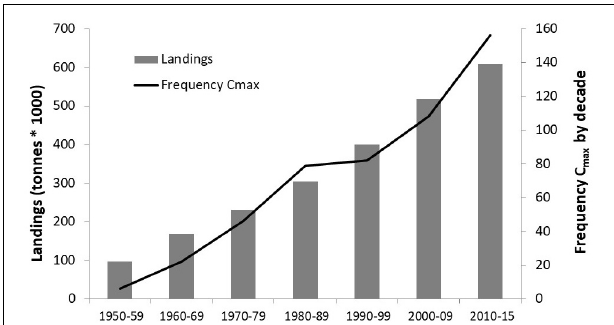
FIGURE 7 | Total landings by decade (average values by fishery) and frequency of fisheries ( n = 499) that achieved their maximum landings (C max ) in each decade between 1950 and 2015.